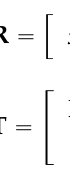
Figure 5. Coordinate transformation and curve derivation along the hand surface at the candidate location: ( a ) transformed image of 3D hand surface points with respect to the reference frame; ( b ) derivation schematic of the curve along the hand surface.